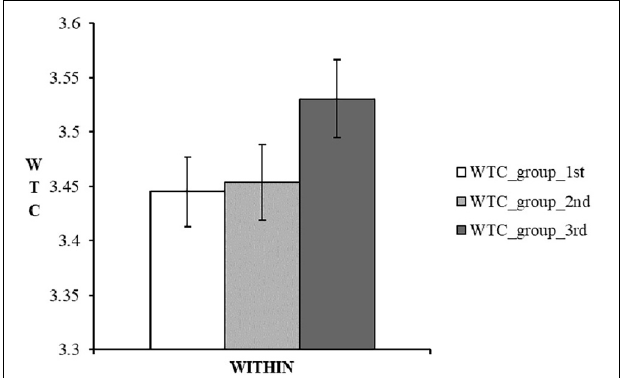
FIGURE 1 | Effects of timing on group-level willingness to communicate (WTC) in